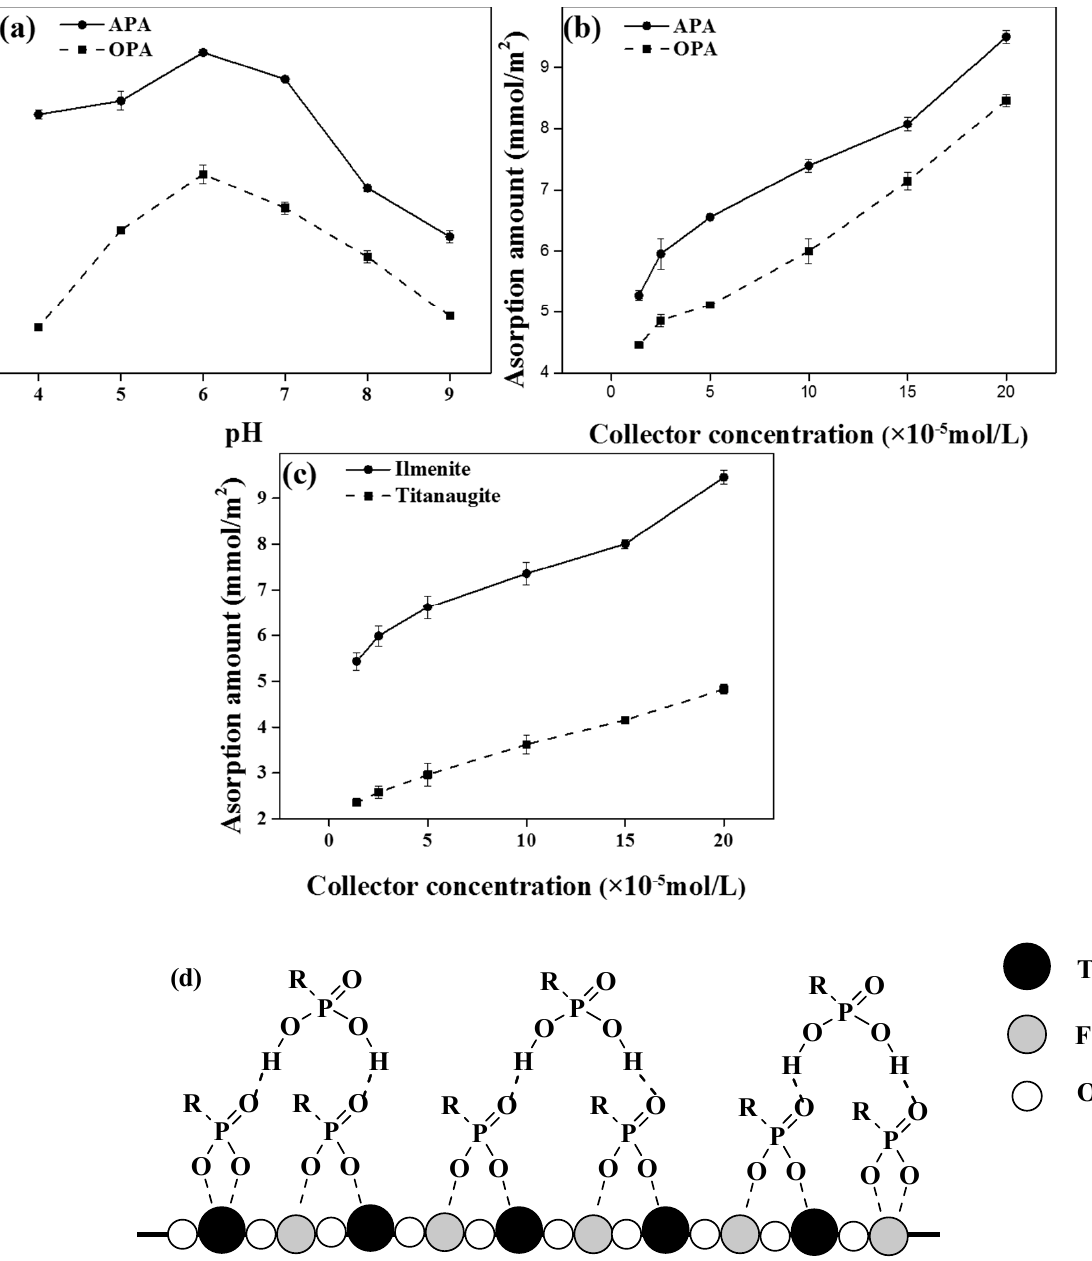
Figure 5. The adsorption amount of APA and OPA onto the surface of ilmenite as a function of pH (( a ), collector concentration = 4 × 10 − 5 M) and collector concentration (( b ), pH value = 6); ( c ) the adsorption amount of APA onto the surface of ilmenite and titanaugite as a function of APA concentration (pH value = 6); ( d ) a proposed adsorption model of APA or OPA onto ilmenite surface.